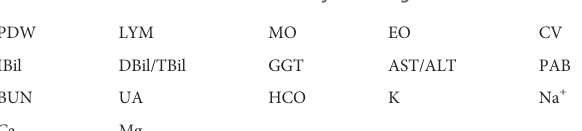
TABLE 5 Nineteen variables screened by lasso regression.